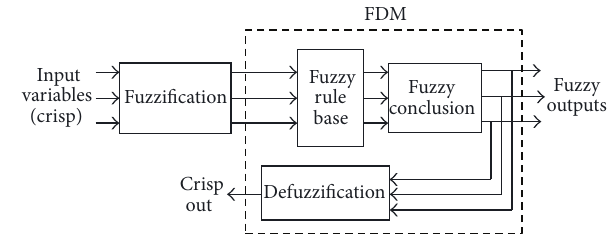
Figure 9: Fuzzy decision